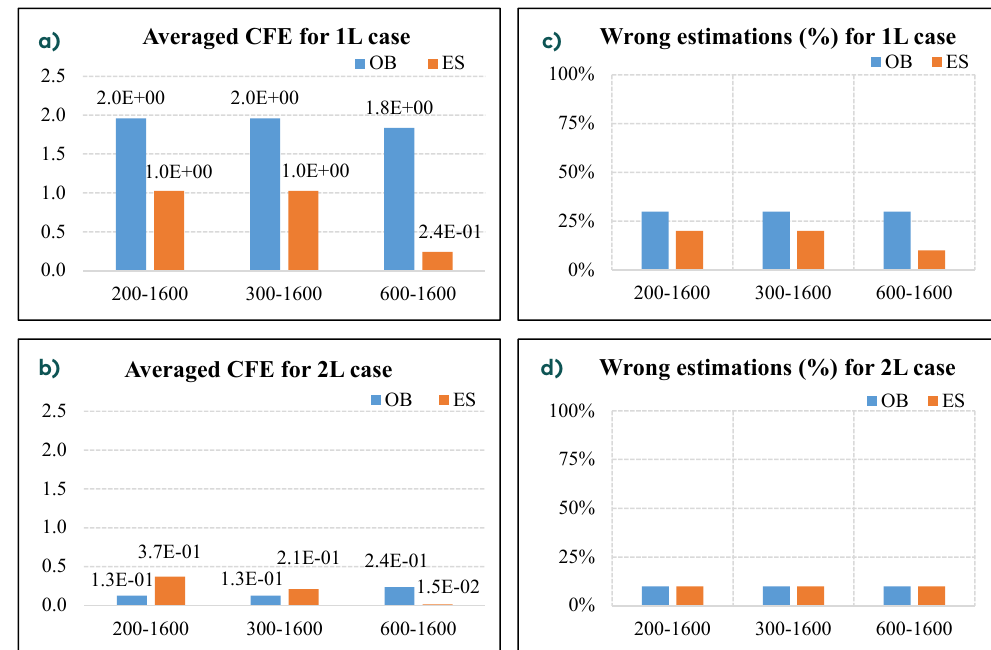
: OB – observed values of resistivity ± 30%. ES – values of resistivity estima- ted trough the curve set up based on free optimization. Figure 10. Averaged CFE for (a) the 1L model and (b) the 2L model, and percentage of wrong estimations for (c) the 1L model and (d) the 2L model